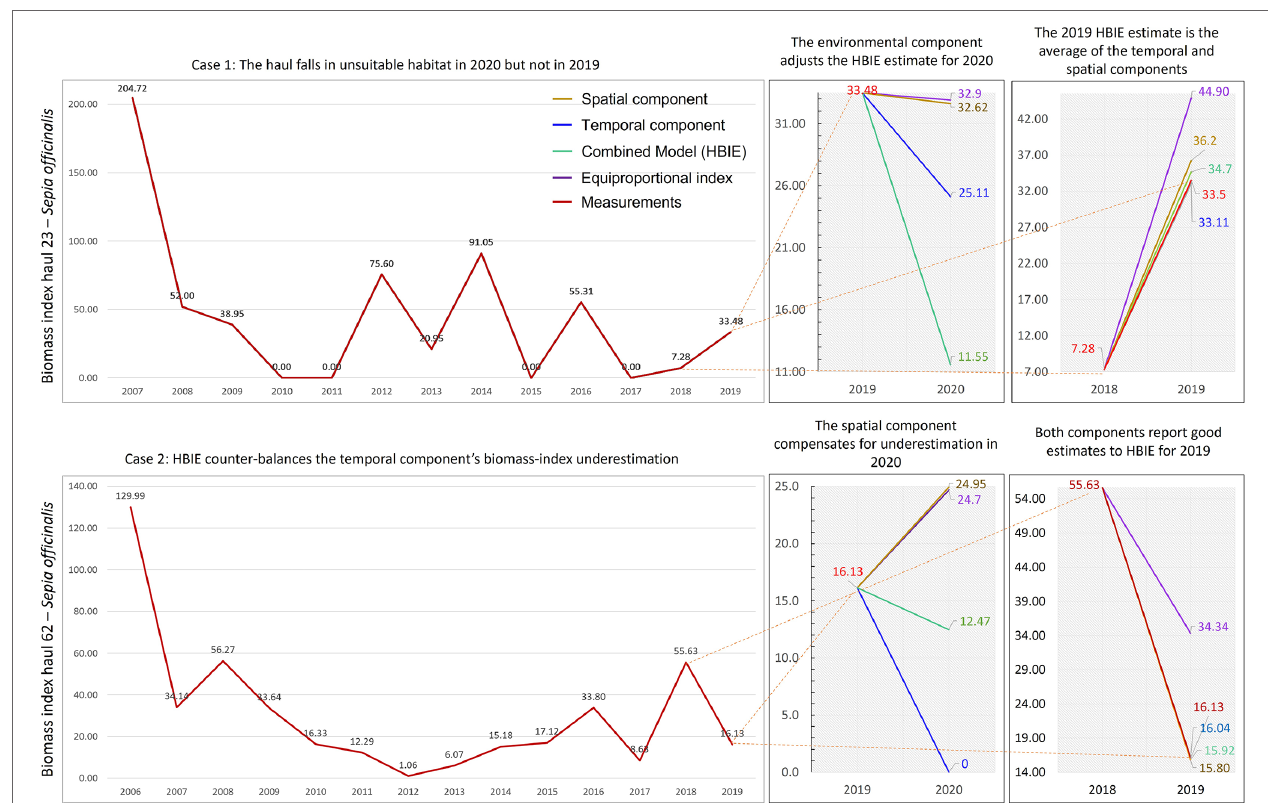
FIGURE 4 | Two cases demonstrating substantial differences between the biomass-index estimates of our combined model (HBIE) and its temporal and spatial components with respect to a baseline estimate (equiproportional index). The two cases show a quasi-periodic and a non-periodical time series, respectively. The rightmost charts report forecasts of 2019 values and comparison with known data. The middle charts report forecasts of 2020 values. The dashed lines highlight the correspondence between the measurements (real data) and the same points in the forecast charts. The colours of the numbers and lines in the forecast charts correspond to the legend